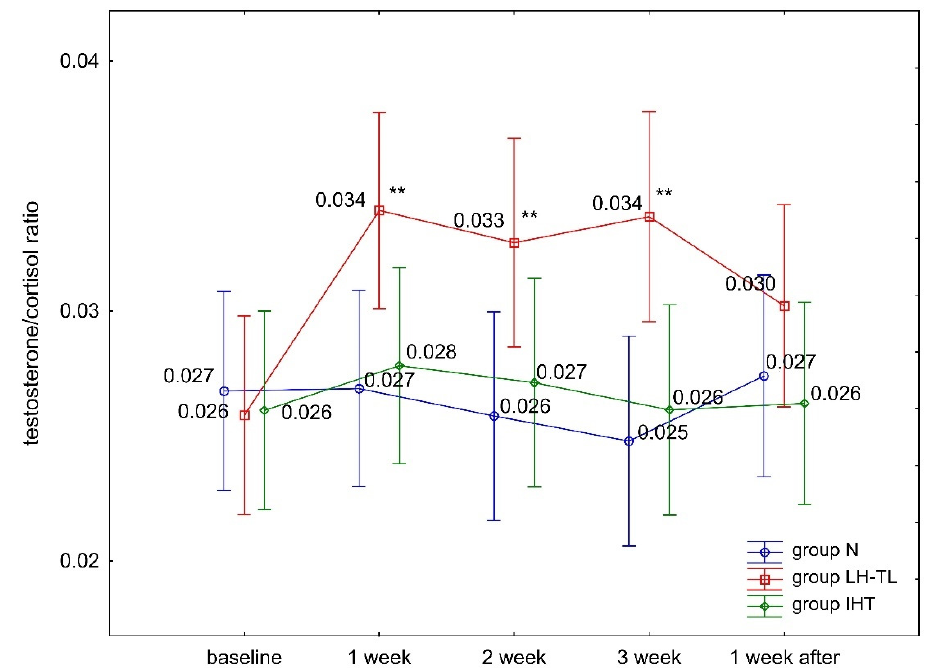
Figure 3. Blood serum testosterone/cortisol ratio (T/C) in experimental (LH–TL and IHT) and control (N) groups during the experiment; ** p < 0.01—statistically significant differences compared to baseline.